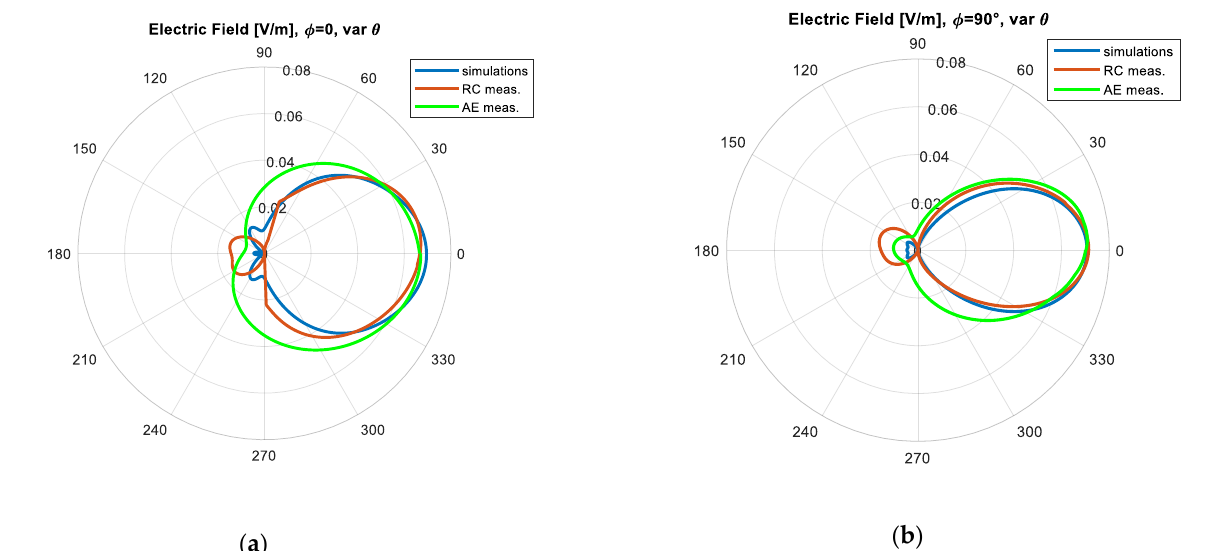
Figure 6. Radiated Emissions at the frequency of 2 GHz: ( a ) plane φ = 0 and ( b ) plane φ = 90 ◦ are shown. The comparison reports numerical simulations (blue line), the prediction based on measurements in RC (red line), and measurements in AE (green line).